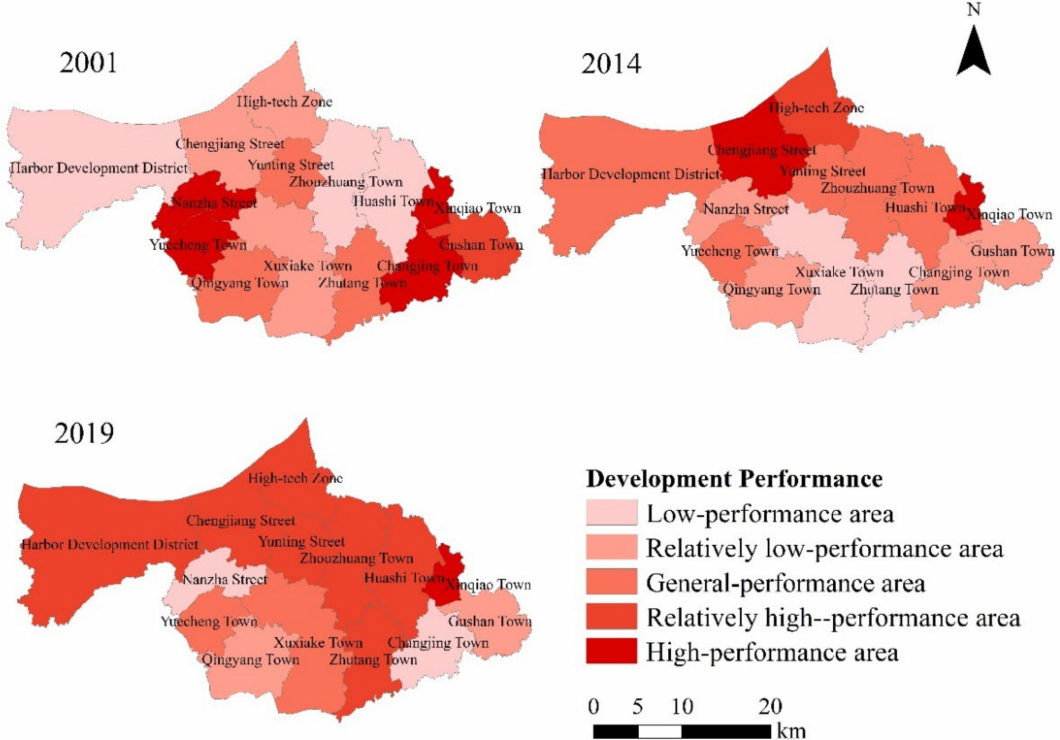
Figure 4. Spatial patterns of the development performance of small towns in Jiangyin from 2001 to